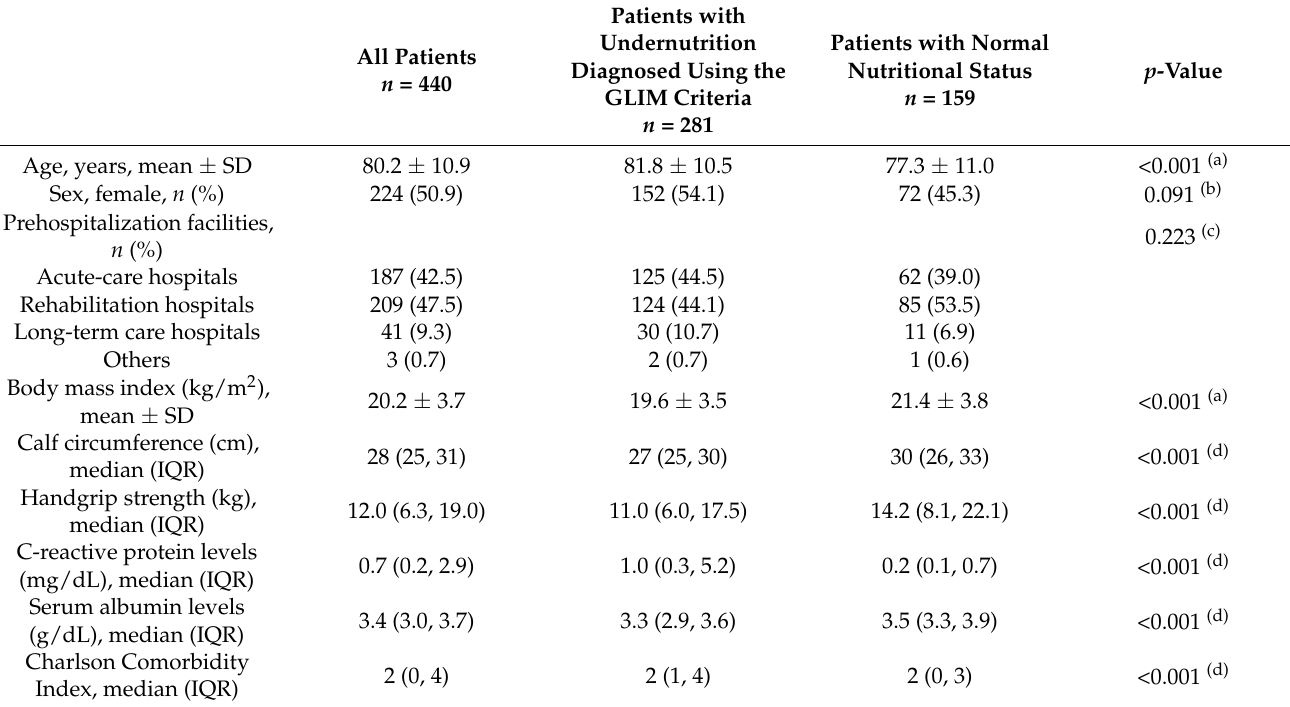
Table 1. Demographic characteristics of the participants at